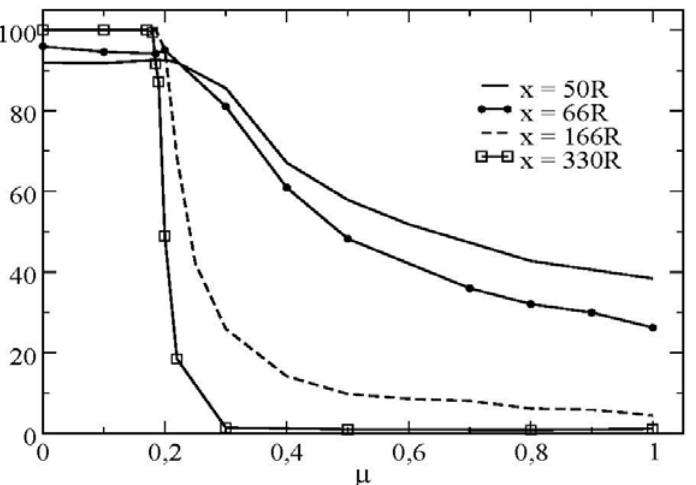
Figure 11. Proportion of sliding contacts cumulated in time as a function of the friction coefficient ( Ω = 500 rpm ; μ ’ =